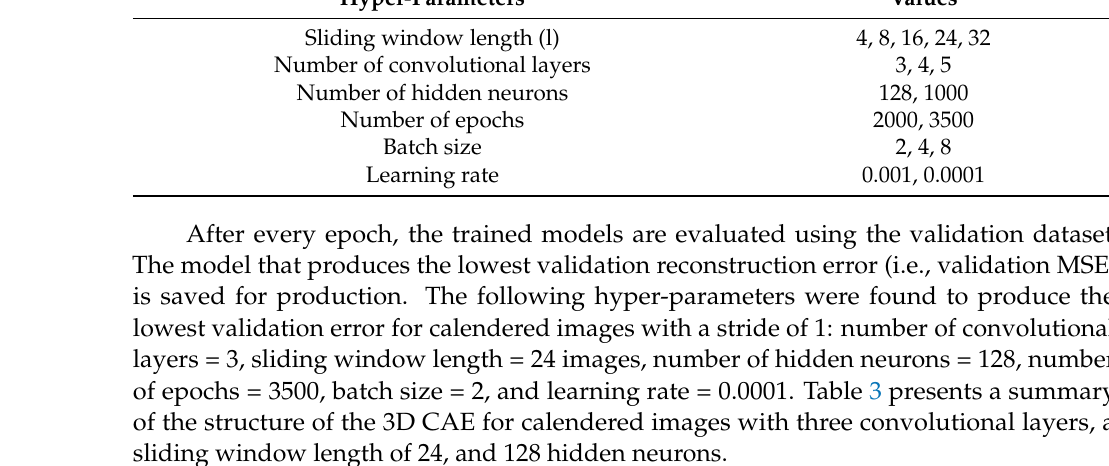
Table 3. A summary of 3D Auto-Encoder-Decoder for processing 3D calendered mini microstructures for case study